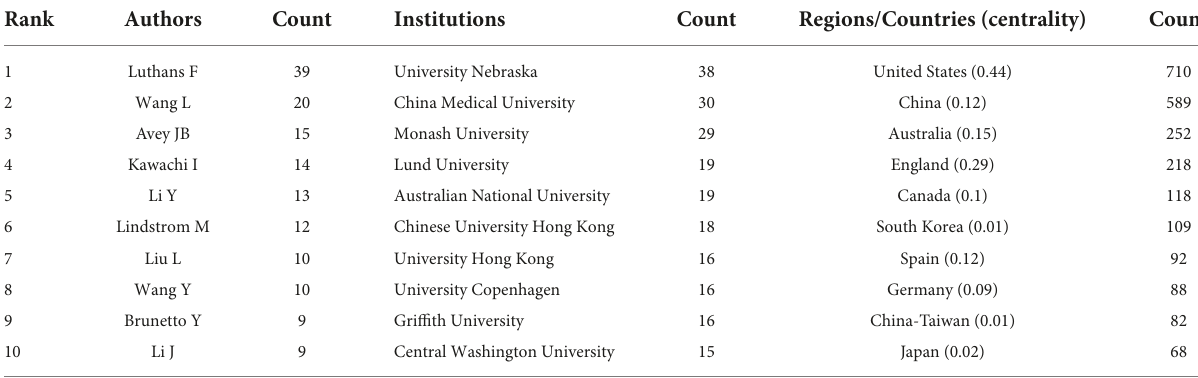
TABLE 3 The top-10 most cooperative authors, institutions and